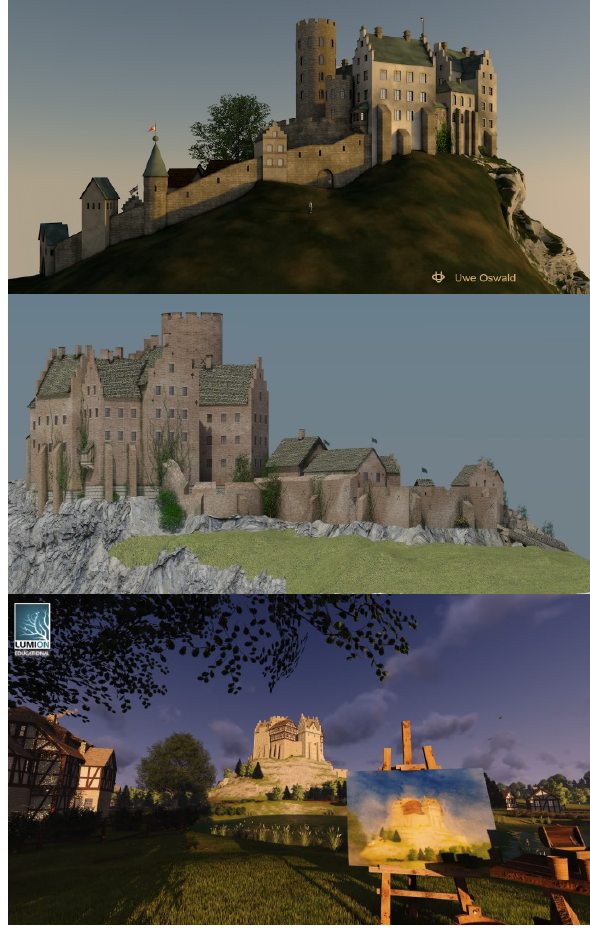
Figure 4. Reconstructed 3D model of the Segeberg castle - Cinema 4D model (top), 3ds Max model (centre), Lumion 3D